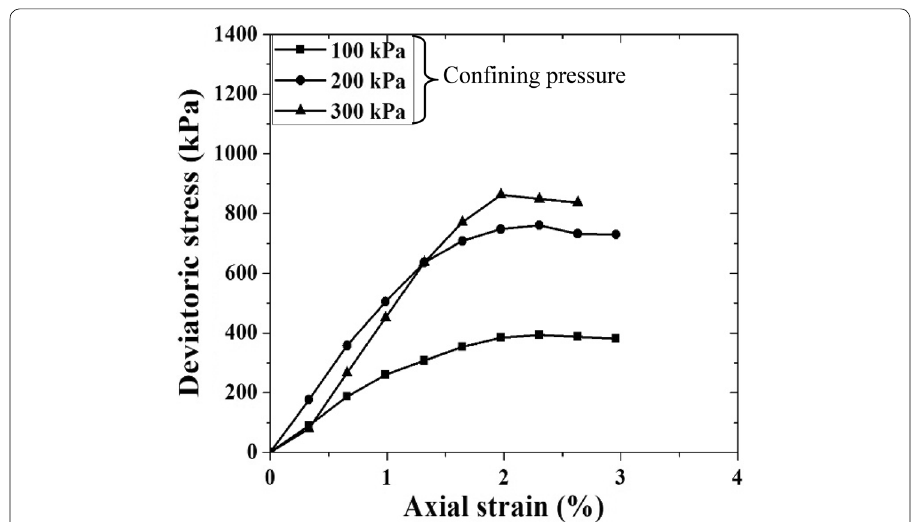
Fig. 17 Stress strain behavior of KTPS fly ash at